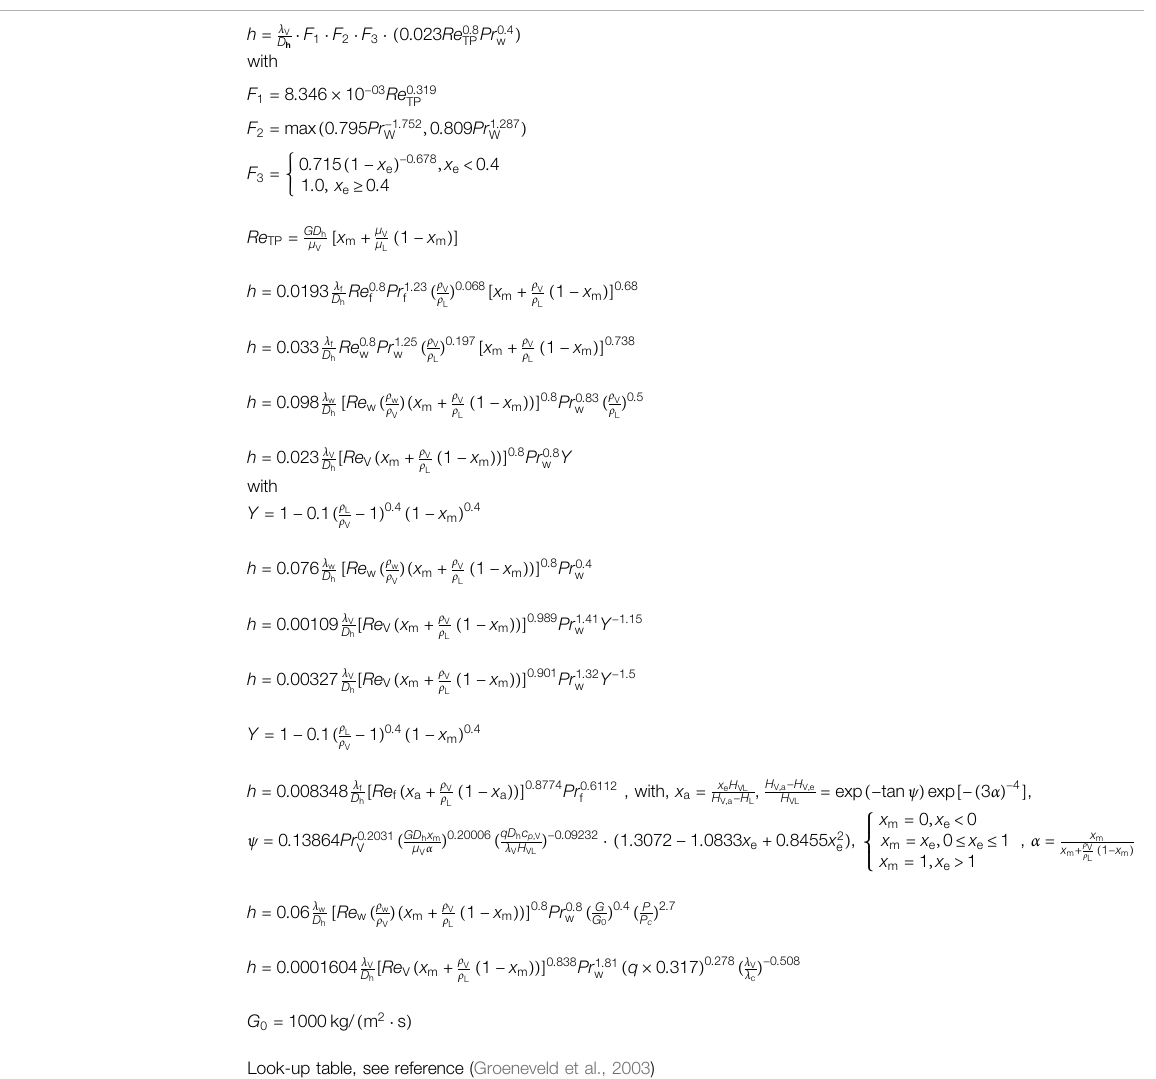
TABLE 6 | Prediction models of post-CHF heat transfer for high-pressure